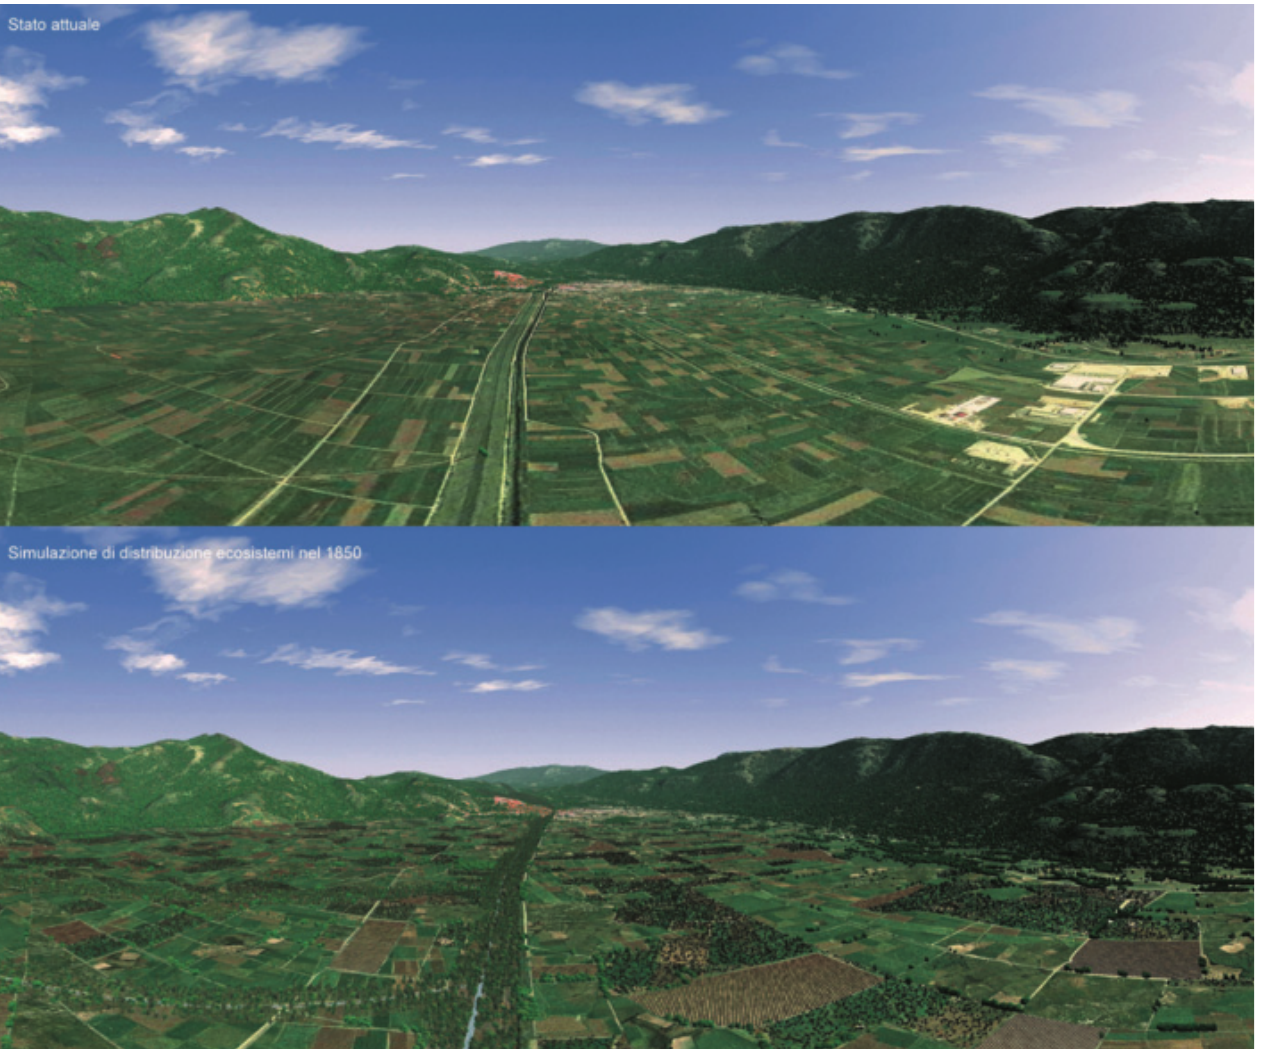
Figure 5. Comparison between the landscape of the Vallo di Diano today (above) and the virtual one of the middle 19th century